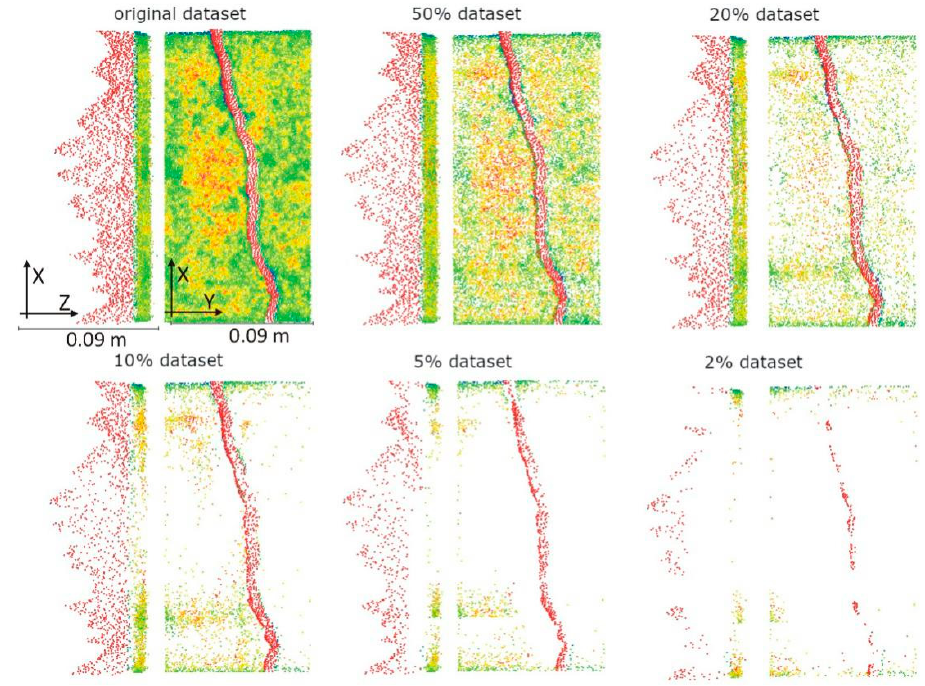
Figure 5. Damage mapping results in a concrete sample using the OptD method.